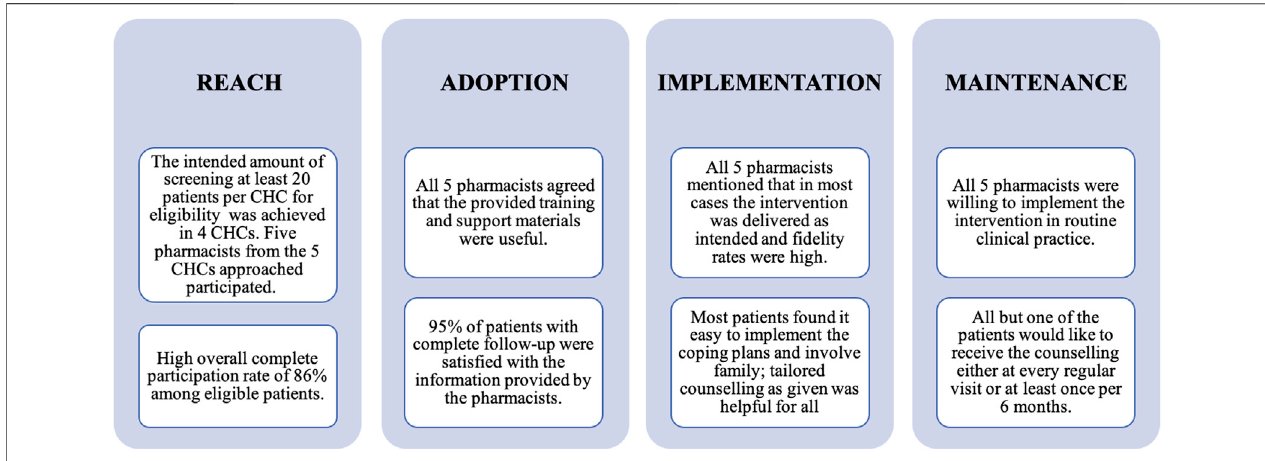
FIGURE 1 | Reach, Adoption, Implementation, and Maintenance dimensions of the RE-AIM* framework from pharmacists ’ and patients ’ perspectives: main fi ndings. Note: *: Effectiveness has been reported in more detail elsewhere (Al fi an et al., 2021).